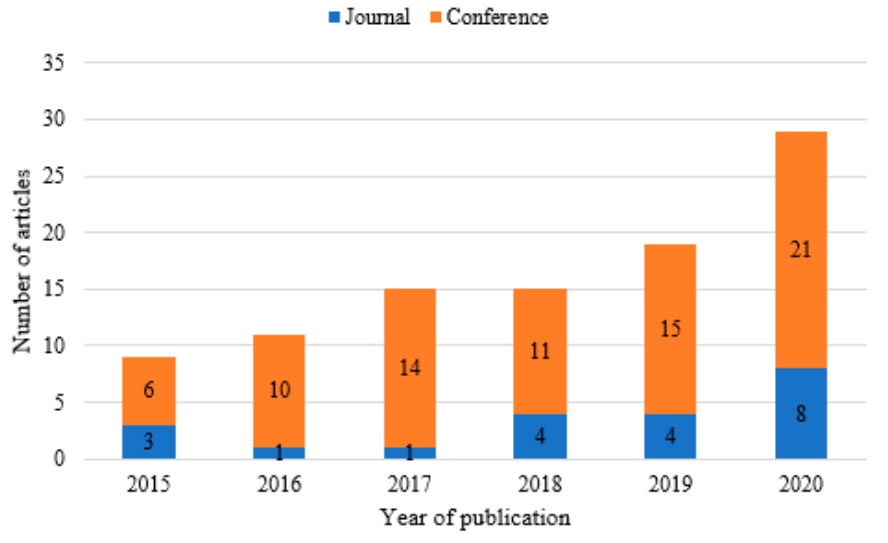
Figure 3. Geographical distribution of the articles included in the systematic review.